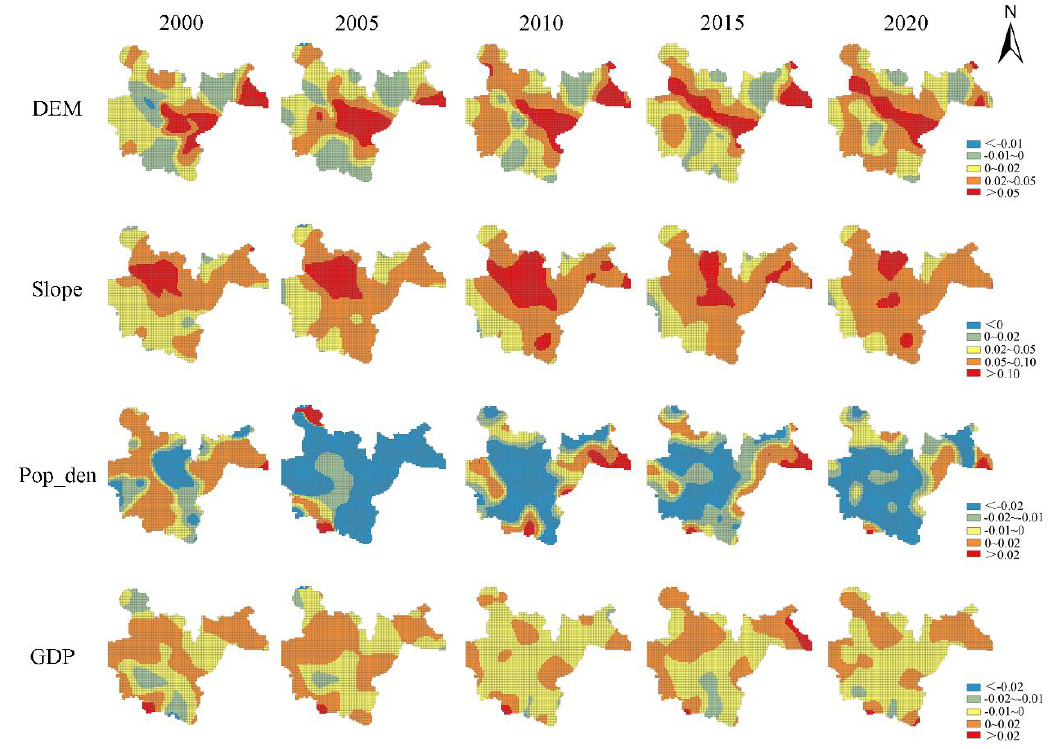
Figure 7. Distribution of the regression coefficients of elevation, slope, population density, and GDP.